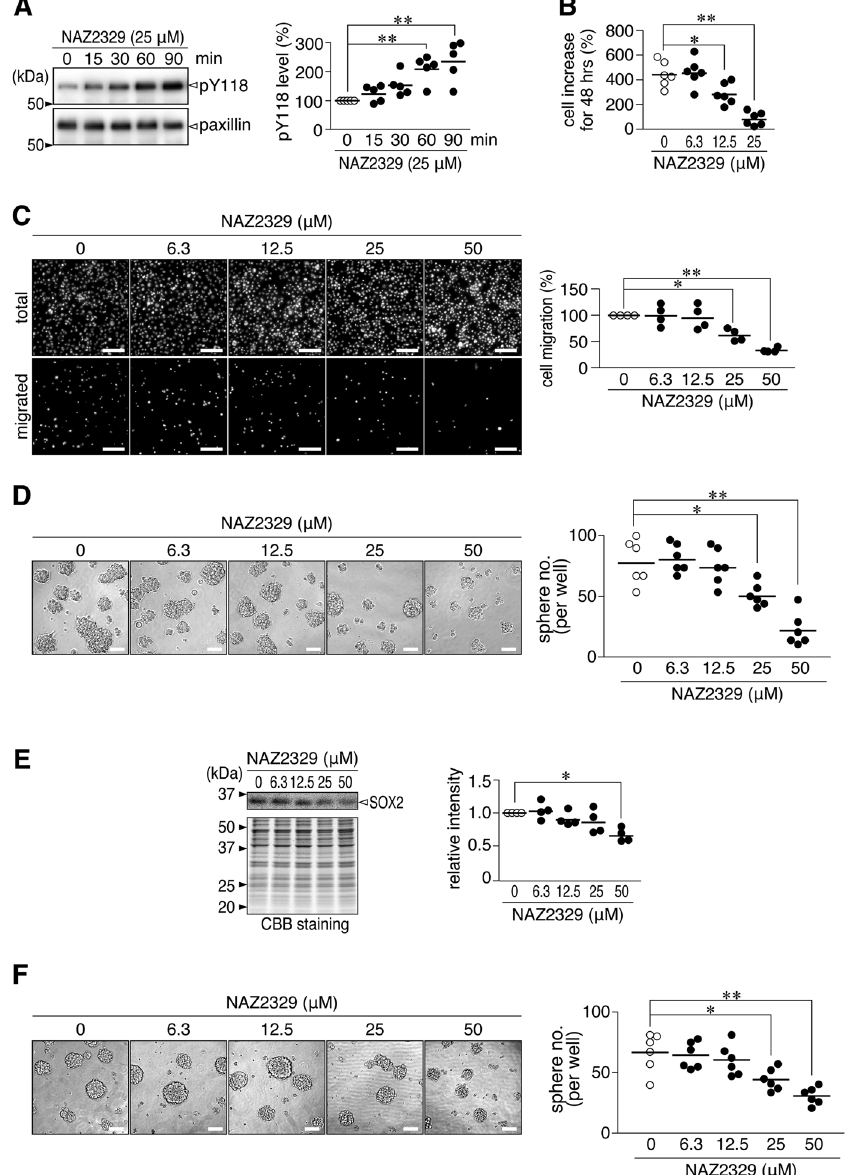
Figure 7. Cellular effects of NAZ2329 on the malignant phenotypes of C6 cells. ( A ) Phosphorylation of paxillin at Tyr-118. C6 cells were incubated with NAZ2329 for the indicated periods. Immunoprecipitated paxillin was analyzed by Western blotting using anti-pY118-paxillin and anti-paxillin. Blots are representative of five independent cultures. The plot shows the intensity of pY118 staining relative to the paxillin level, normalized to the vehicle control in each experiment. ** P < 0.01, significantly different from the vehicle by one-way ANOVA with Bonferroni post hoc tests). ( B ) Cell proliferation assay. C6 cells were incubated for 48 h with NAZ2329 in normal medium containing 2% FBS. The plot shows the percentage increase in the cell number. * P < 0.05, ** P < 0.01 (one-way ANOVA with Bonferroni post hoc tests). ( C ) Boyden chamber assay. Cells were allowed to migrate for 3 h. DAPI-stained nuclei are shown before (total) and after (migrated) the removal of cells remaining in the top chamber. Scale bars, 100 µ m. The plot shows the migrated cell number normalized to the vehicle. * P < 0.05, ** P < 0.01 significantly different from the vehicle (one-way ANOVA with Bonferroni post hoc tests). ( D , E ) Sphere formation ( D ) and SOX2 expression ( E ). C6 cells were cultured in CSC medium for 7 days with indicated concentrations of NAZ2329. Images are representative of five independent cultures. Scale bars, 100 µ m. The plots show the sphere number per well (D) and staining intensity of SOX2, normalized to the vehicle ( E ). * P < 0.05, ** P < 0.01 significantly different from the vehicle (one-way ANOVA with Bonferroni post hoc tests). ( F ) Self-renewal of C6 spheres. C6 spheres were initially developed in CSC medium for 7 days, followed by an incubation with NAZ2329 in CSC medium for 5 days. Images are representative of five independent cultures. Scale bars, 100 µ m. The plot shows the sphere number per well. * P < 0.05, ** P < 0.01 (one-way ANOVA with Bonferroni post hoc tests). Full-length blots and gels are presented in Supplementary Fig.